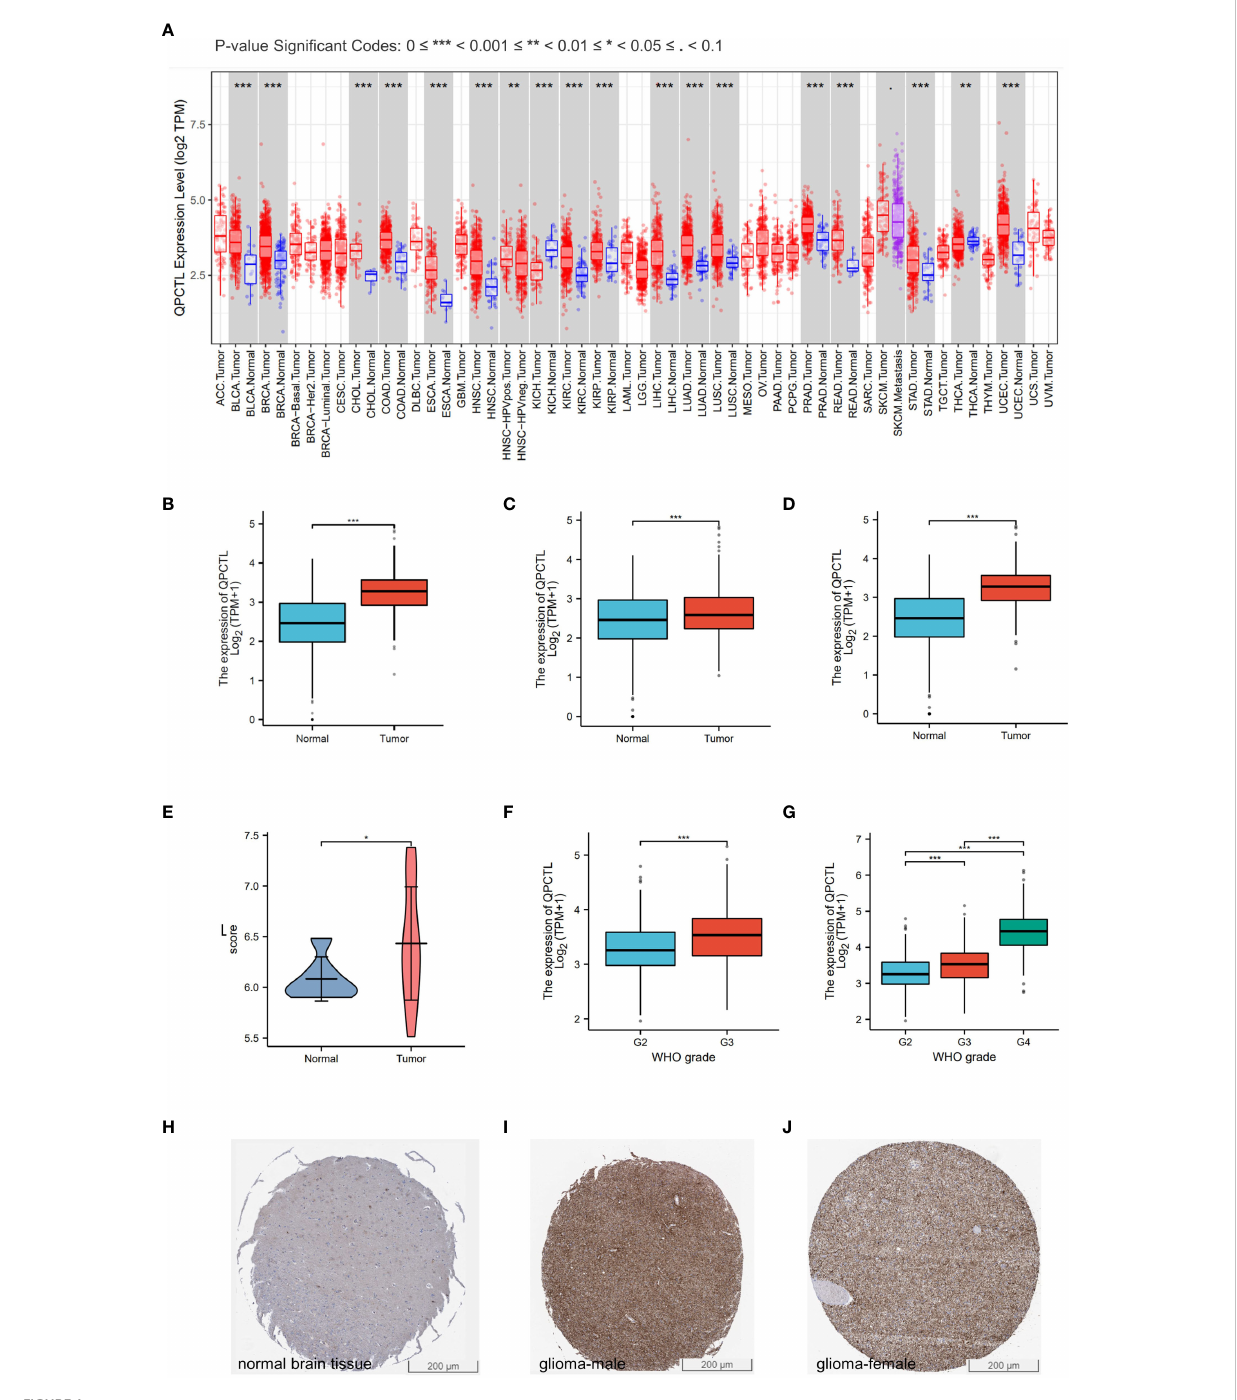
FIGURE 1 Higher QPCTL expression in tumor samples than that in normal tissues. (A) QPCTL expression at the mRNA level in pan-cancers, data from the TIMER database. (B – D) TCGA data show different QPCTL expression at mRNA levels in normal tissue and LGG (B) , GBMLGG (C) , and GBM (D) . (E) Different QPCTL expression in normal and low-grade glioma in the GEO database. (F, G) The expression of QPCTL in different stages of glioma in LGG (F) and GBMLGG (G) . (H – J) QPCTL protein expression in normal brain tissue and glioma tissue, data from the Human Protein Atlas. * p < 0.05; ** p < 0.01; *** p <